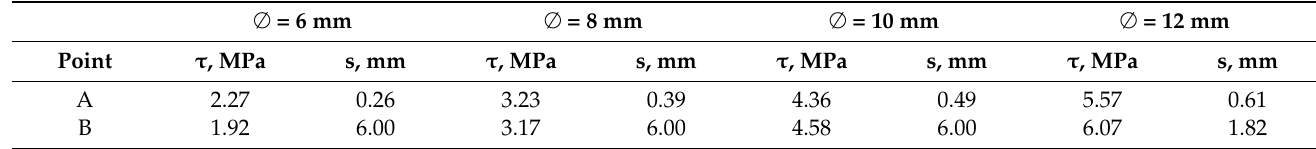
Table 4. Shear stress and slip values of interfaces with different connector